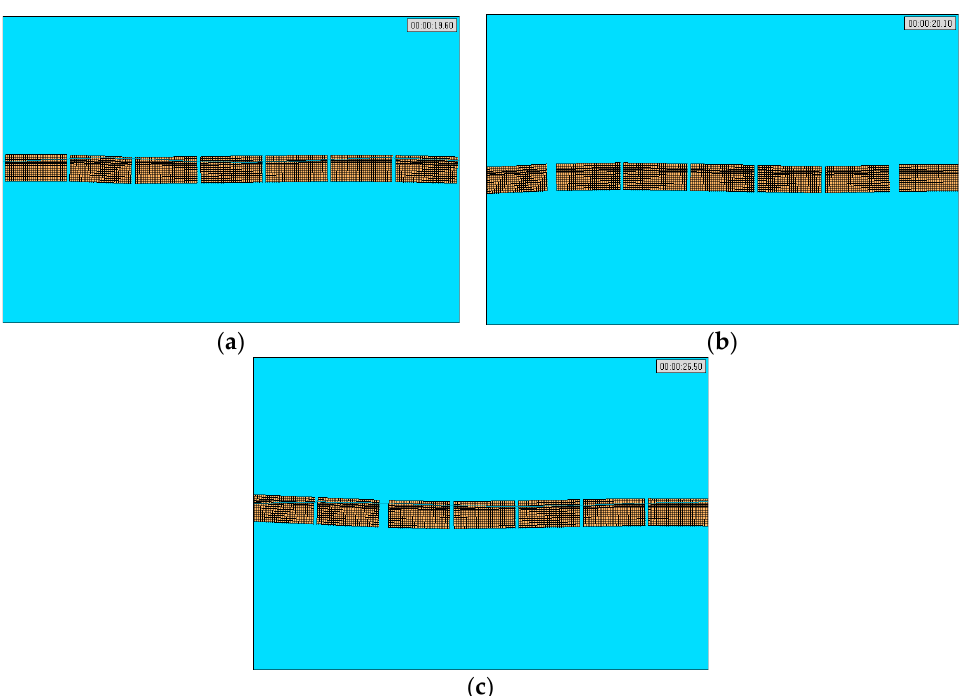
Figure 12. Representative transient responses of three expansion scheme (T = 11 s): ( a ) scheme A; ( b ) scheme B; and ( c ) scheme C.